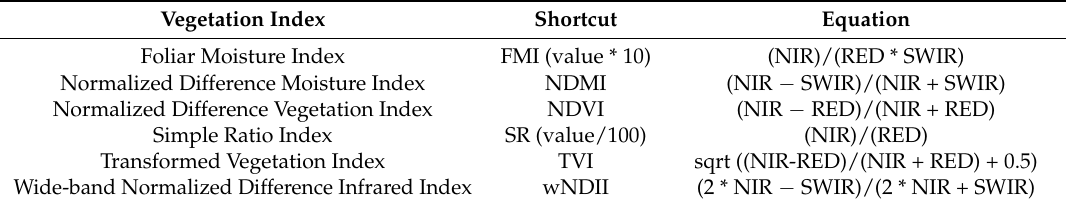
Table 5. List of the vegetation indices and their expressions. Vegetation